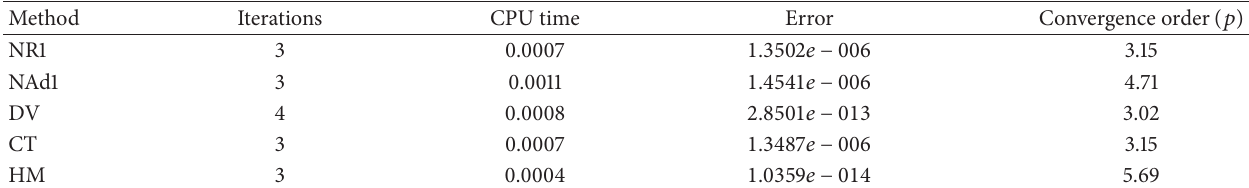
Table 2: Numerical results of Example 2 with initial value 𝑥 0 = (0.3,−0.3) 𝑇 .